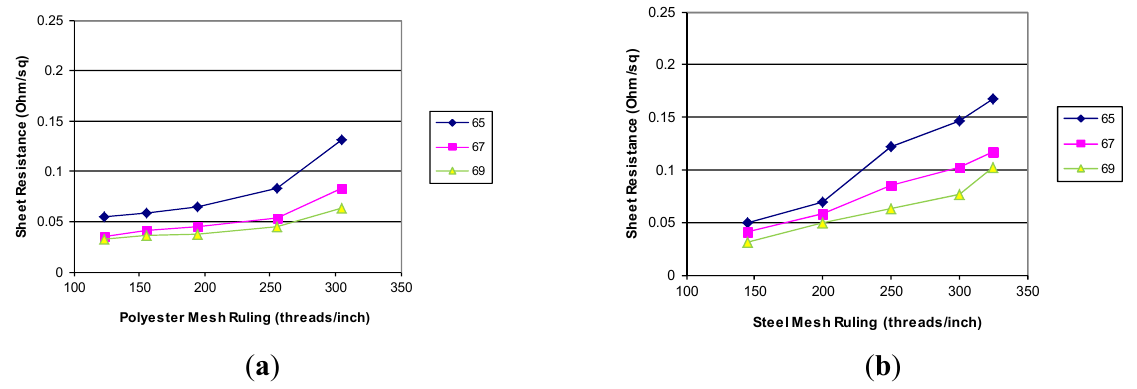
Figure 5. The effect of mesh ruling on the paste sheet resistance printed through the ( a ) polyester and ( b ) stainless steel meshes for each silver